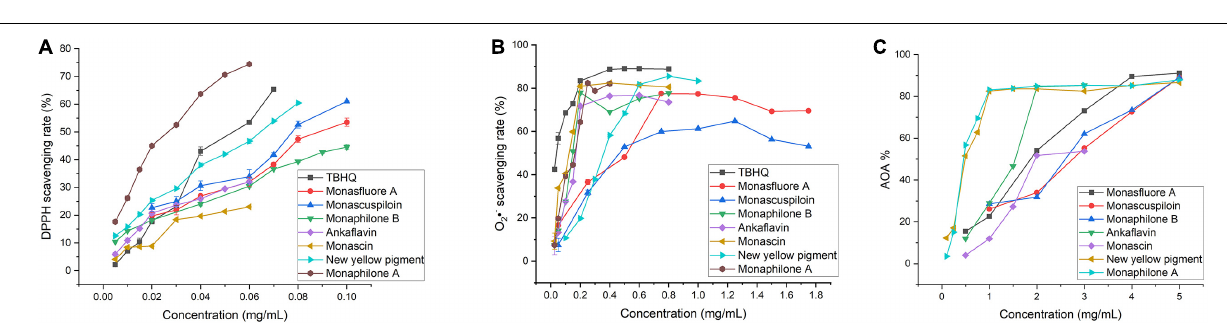
FIGURE 7 | In vitro antioxidant of yellow pigments purified from functional Qu (FQ) and coloring Qu (CQ). (A) The DPPH radical scavenging activity of yellow pigment from FQ and CQ. (B) The superoxide anion radical scavenging activity of yellow pigment from FQ and CQ. (C) The inhibition rate of yolk lipoprotein peroxidation of yellow pigment from FQ and